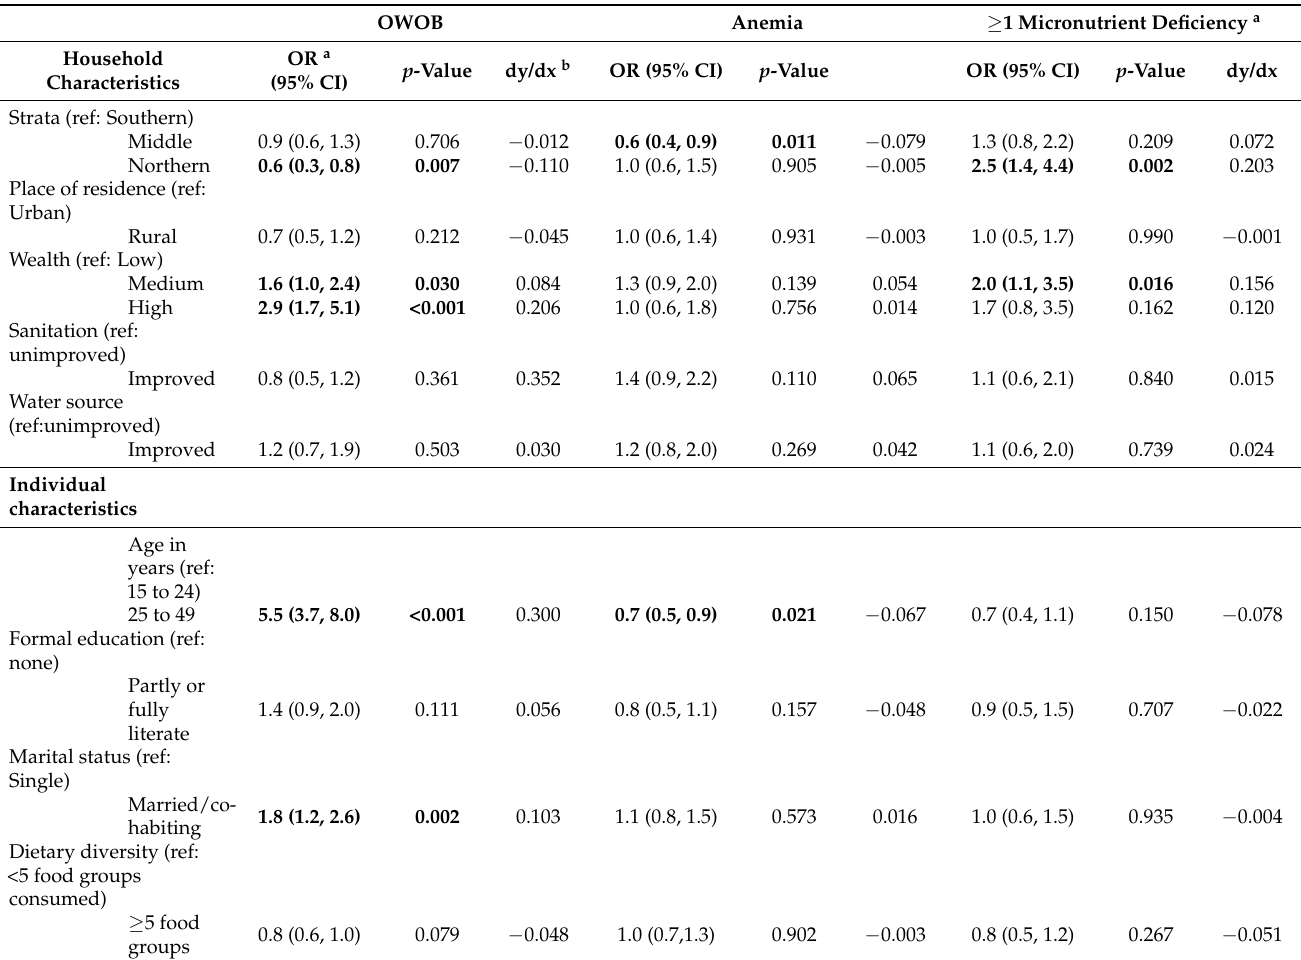
Table 4. Logit regression analysis of the correlates of the co-occurrence of